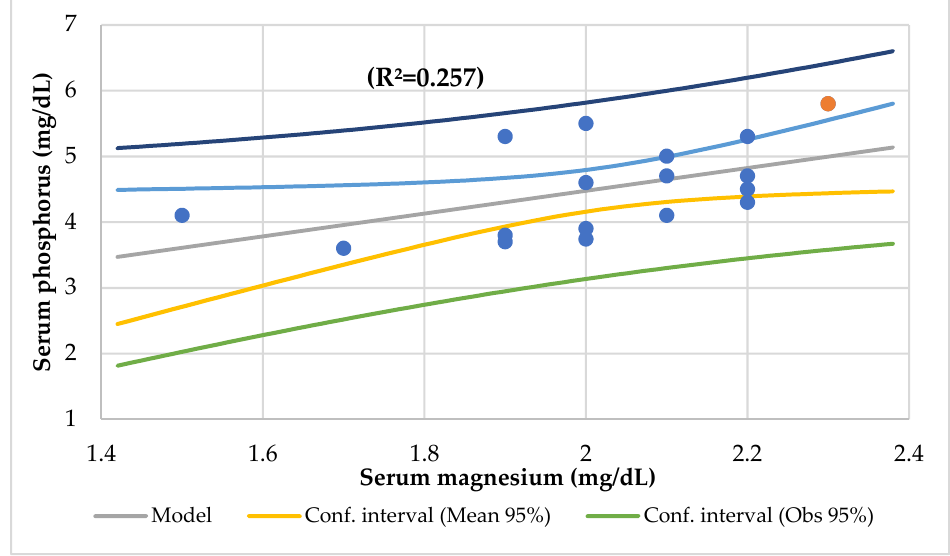
Figure 4. Regression serum phosphorus (mg/dL) by serum magnesium (mg/dL).